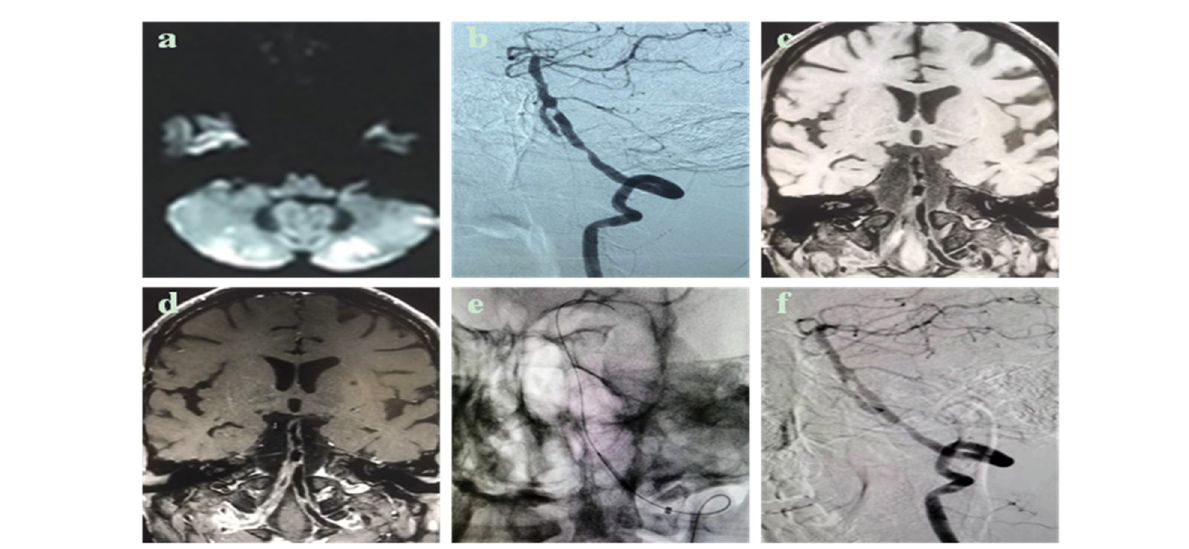
FIGURE1 Case description: Male, 50 years old, admitted to the hospital for 1 month due to dizziness and walking instability, who was treated in an external hospital, and the head magnetic resonance imaging showed multiple acute cerebral infarctions in both cerebellar hemispheres. He has a history of hypertension and cerebral infarction and has received antiplatelet and lipid-lowering therapy. Have a history of smoking. Cerebral angiography shows occlusion of the medial segment (V4) of the right vertebral artery and severe tandem stenosis of the V4 segment of the left vertebral artery. After admission, high-resolution magnetic resonance imaging of the intracranial vascular wall was completed, suggesting that the V4 segment of the left vertebral artery was a narrowing caused by atherosclerotic plaque. (a) Cranial MRI DWI sequence shows multiple points and flaky hyperinflation of the cerebellar hemisphere on both sides; (b) cerebral angiography sees occlusion of the V4 segment of the right vertebral artery, 70% of the proximal stenosis of the V4 segment of the left vertebral artery, and 90% of the proximal fusion segment of the distal, proximal fusion segment; (c,d) high-resolution MRI vascular wall imaging shows an eccentricity of the V4 segment of the left vertebral artery, focal thickening, local bleeding in the plaque, plaque strengthening; (e,f) The left vertebral artery V4 segment tandem stenosis lesion is pre-dilated sequentially with a balloon of 2.0mm × 15mm. The proximal stenosis was placed with a 3mm × 13mm spherical expansion stent, and the distal stenosis was placed with a 2.5mm × 10mm spherical expansion stent, and the post-operative angiography showed that the left vertebral artery V4 segment tandem stenosis improved, and the residual stenosis ≤